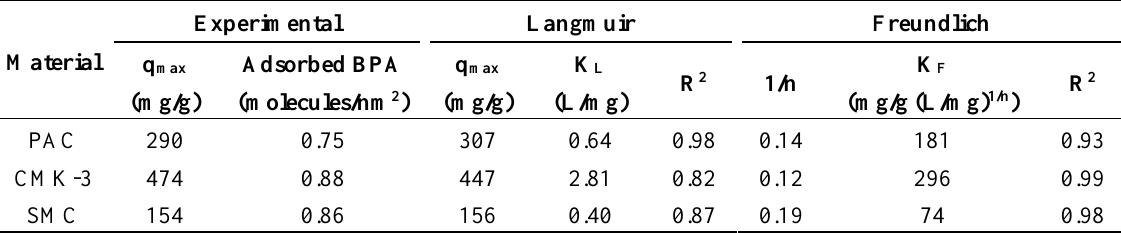
Figure 4. Adsorption isotherms of 10 mg of CMK-3 (■), PAC (●) and SMC (▲) in 100 mL of bisphenol-A (BPA)-solution, experimental data were fitted with the Langmuir and Freundlich model, the error bars represent the standard deviation of the triplicate measurements. Table 3 . The observed maximum adsorption capacity in mg/g and converted to molecules per nm 2 , parameters describing the adsorption isotherms of BPA on PAC, CMK-3 and SMC modeled by Langmuir and